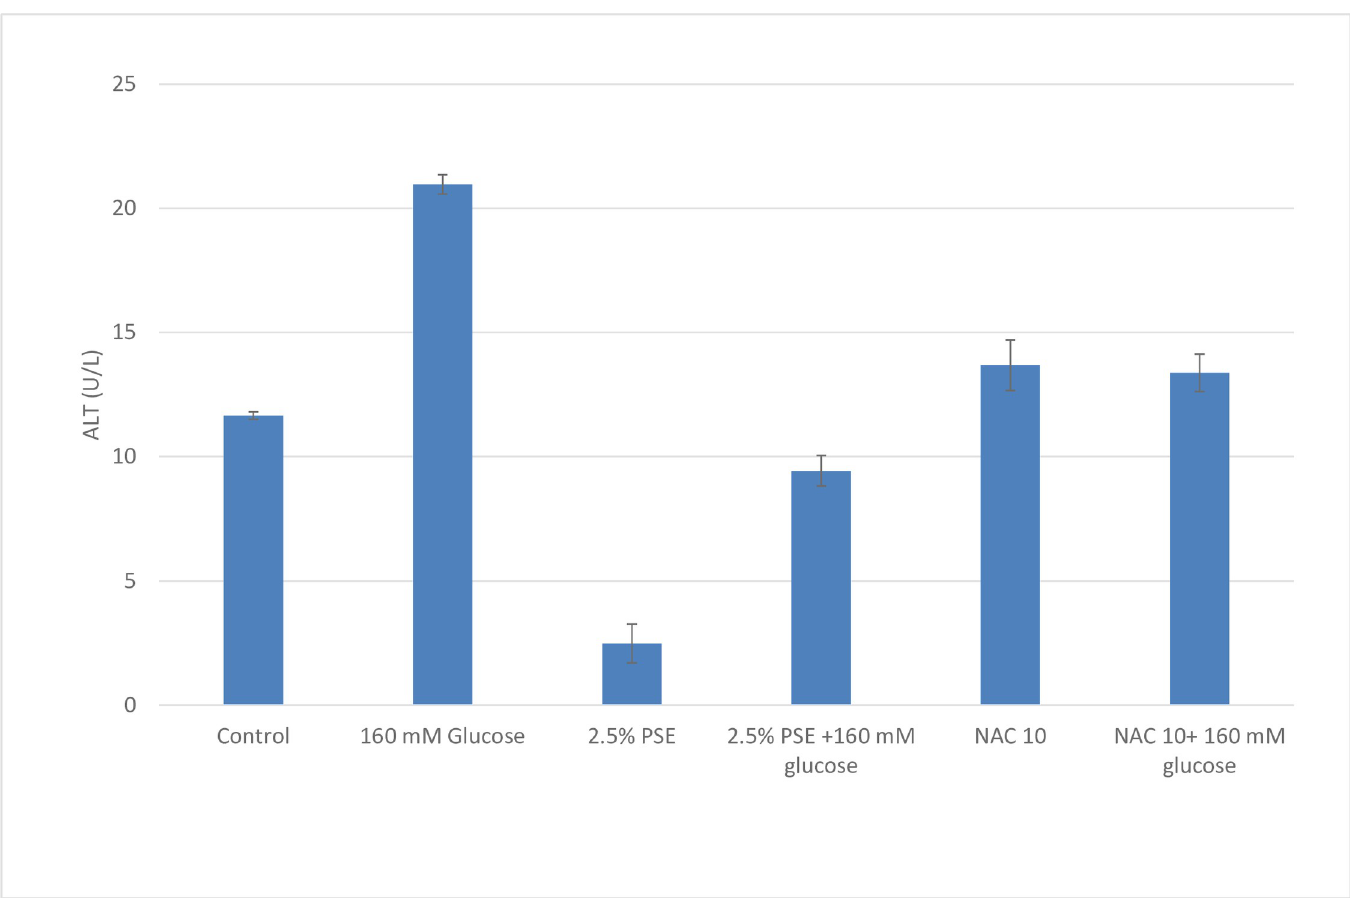
Fig 6. Protective effect of PSE on ALT leakage from HepG2 cells. HepG2 cells were exposed to either glucose, peanut skin extract (PSE), glucose and peanut skin extract (PSE), n-acetyl cysteine (NAC) or n-acetyl cysteine and glucose for 24 hours. N-acetyl cysteine is an antioxidant and used as a positive control. Each treatment was done in triplicate and data are expressed as mean ± SEM. � Indicates statistically significant difference at P < 0.05.